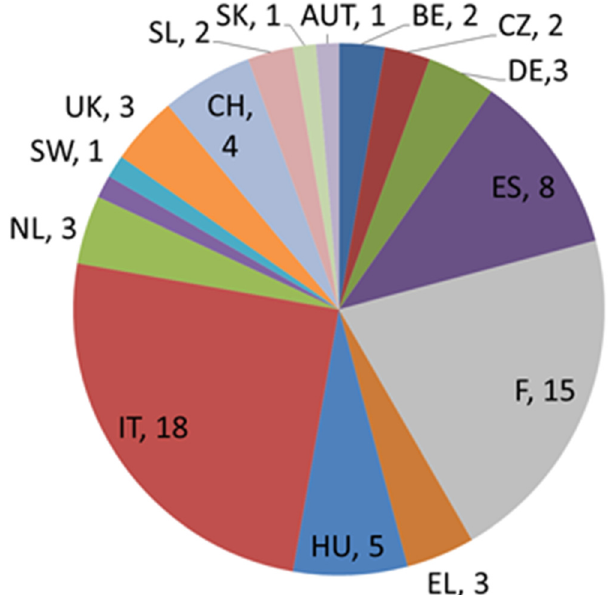
Fig. 7. Breakdown per Country of the 74 SRE attendants in the GENTLE